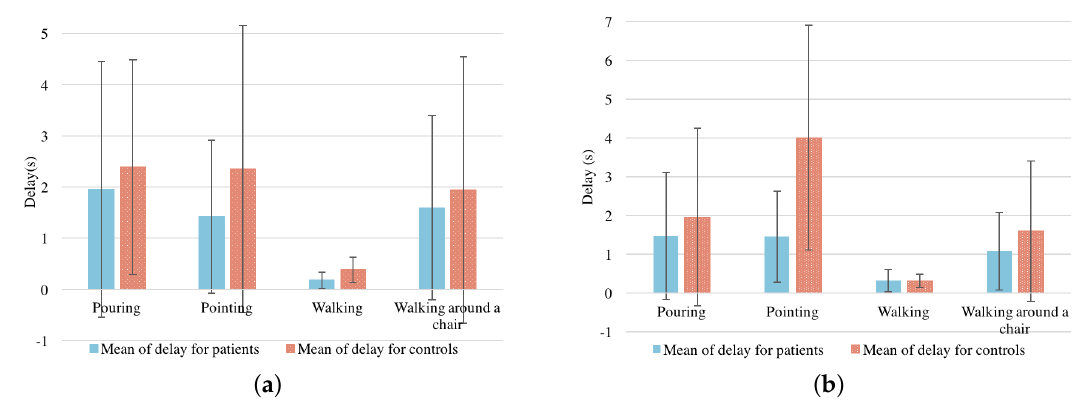
Figure 5. Mean ( µ ) ± standard variation ( σ ) of the delay time between sensors: ( a ) Mean ( µ ) ± standard variation ( σ ) of the delay time between Sensor 2 and Sensor 3, ( b ) Mean ( µ ) ± standard variation ( σ ) of the delay time between Sensor 2 and Sensor 4.